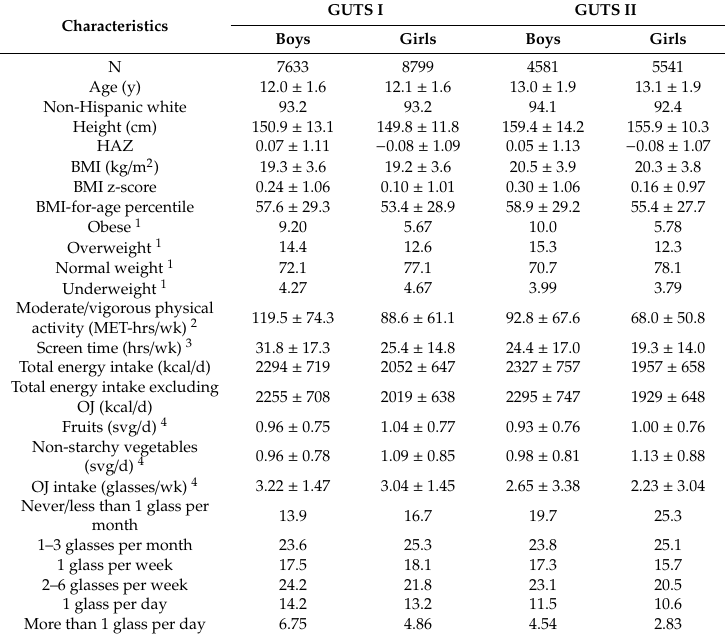
1 Categorization on the basis of cuto ff s defined by U.S. Centers for Disease Control and Prevention (2016 update). Obese: BMI-for-age ≥ 95th percentile; overweight: 95th > BMI-for-age ≥ 85th percentile; normal weight: 85th > BMI-for-age ≥ 5th percentile; underweight: BMI-for-age < 5th percentile. 2 Total metabolic equivalent (MET) hours per week calculated by summing the time spent participating in various sports, games and intentional exercise (not including activities with MET values < 4 such as walking and “playing outdoors” in GUTS I). 3 Including television and VCR / DVD videos, video games and computer / internet. 4 Glasses consumed were calculated from the